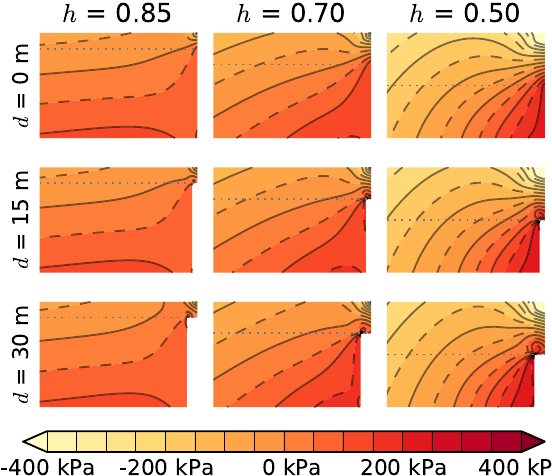
Fig. 2. Comparison of first principal Cauchy stresses, relative to hydrostatic pressure, for a variety of water depths and undercut lengths, assuming uniform undercutting. Grey dashed line indicates water level. 4 Wet calving multiplier